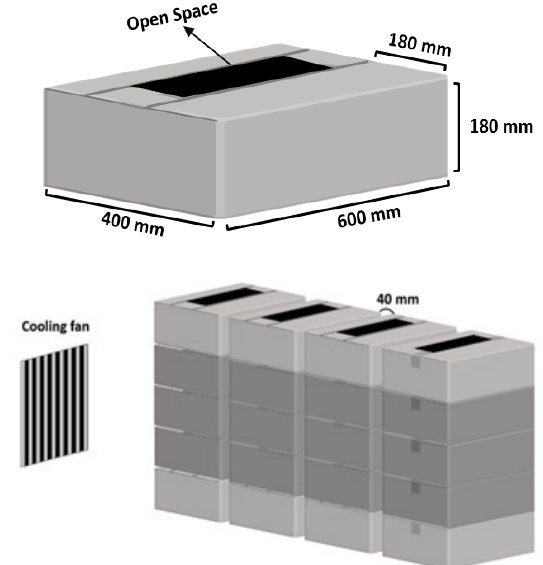
Fig. 2: Position of corrugated boxes inside the storage room. Dark grey boxes indicate the positions of the sample boxes. Light grey boxes in the top and bottom rows and one third of dark grey boxes indicated empty boxes for